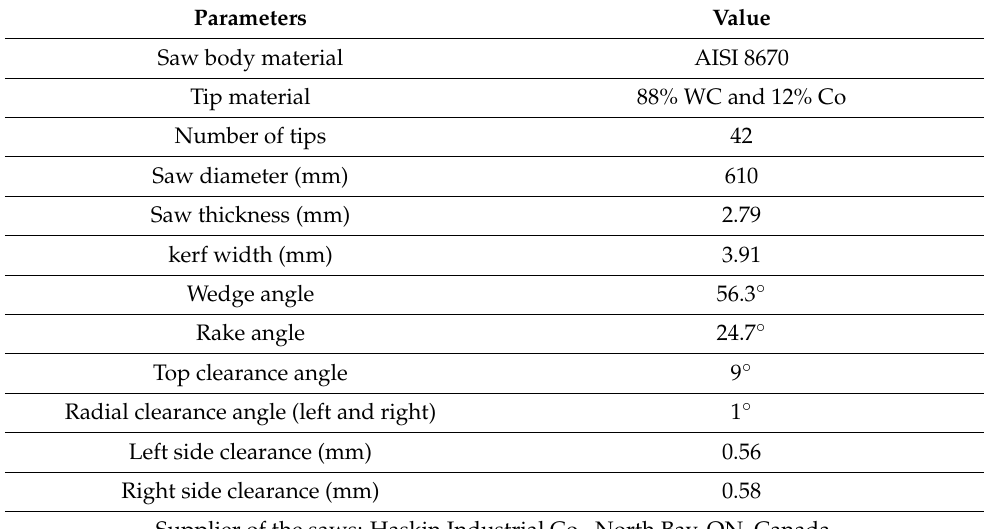
Table 2. Circular saw